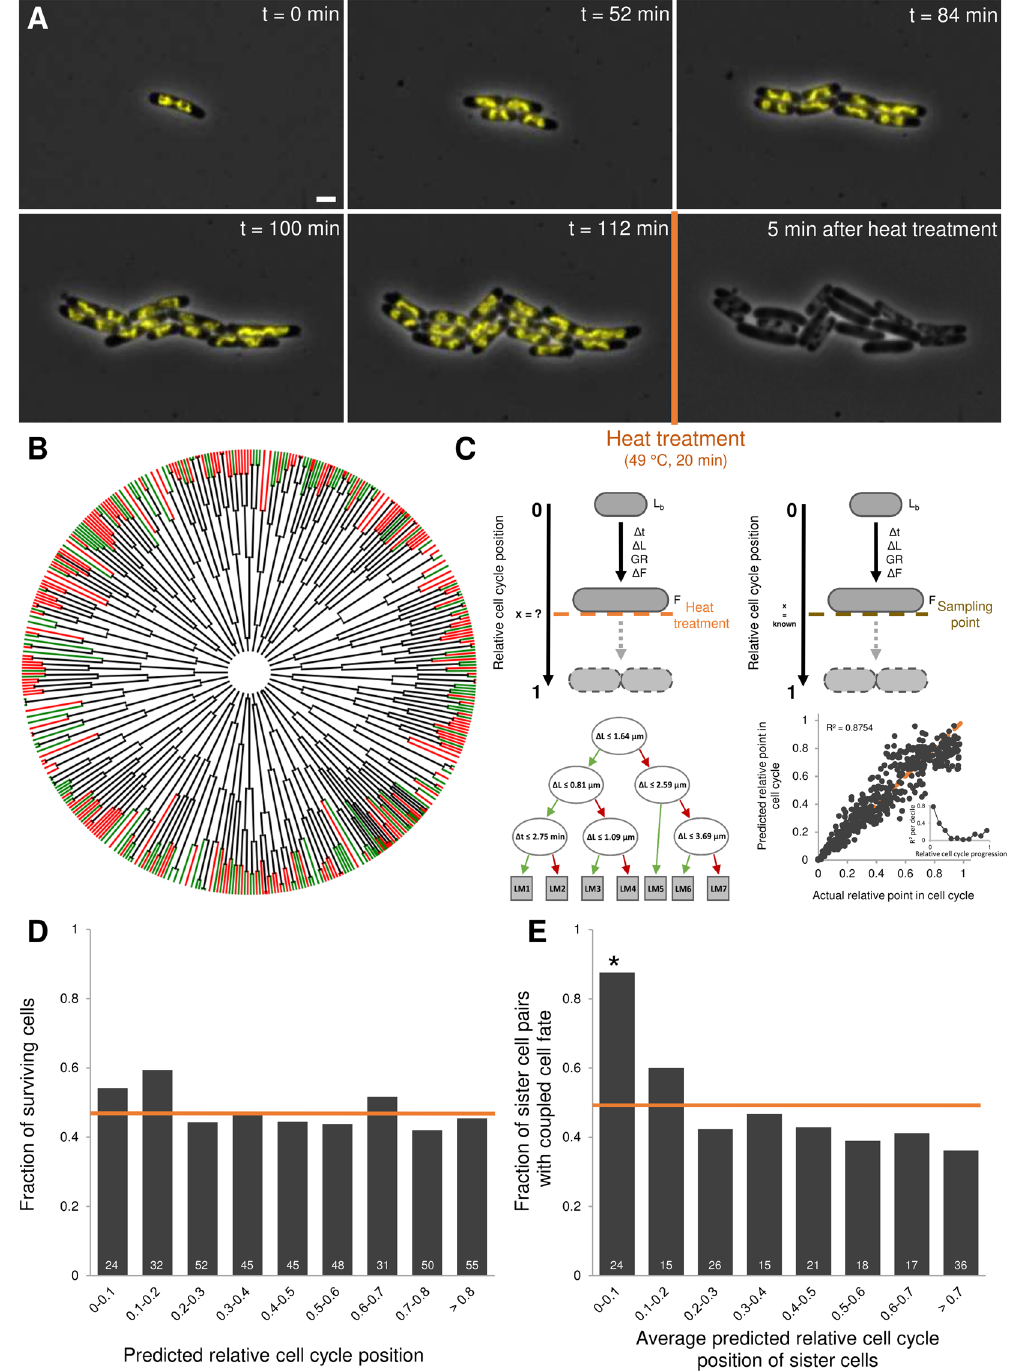
Figure 1. Single-cell level survival-assay reveals rapid sister cell individualization. ( A ) Representative images of a TLFM microscopy image sequence of growing MG1655 hupA-yfp cells at indicated times before and after heat treatment (49 °C, 20 min). Phase contrast images are superimposed with YFP epifluorescence images (reporting nucleoid dynamics). The scale bar corresponds to 2 μ m. ( B ) Schematic representation of all observed microcolonies (n = 29) and cells (n = 821). Every end point in the tree represents one cell exposed to the heat treatment (n = 425); green tips: surviving cells, red tips: non-surviving cells. ( C ) Schematic representation of our survival-assay (top left) and sampling approach (top right; based on training data from unstressed cells). As cells grow, many measurable cellular attributes (Lb = length at birth, Δ t = time since birth, Δ L = length increase since birth, GR = growth rate, Δ F = increase in cellular DNA content, F = cellular DNA content) can be employed to predict a cell’s relative position in its cell cycle at the moment of heat treatment (x). The model itself consists of 7 linear models (LM) preceded by a regression tree. Green arrows indicate a positive answer, red arrows a negative answer. The performance of the model was assessed by 10-fold internal cross- validation (n = 635; R² = 0.8754, p-value = 6.17 × 10 − 221 , RMSE = 0.100). The bisector is shown as a